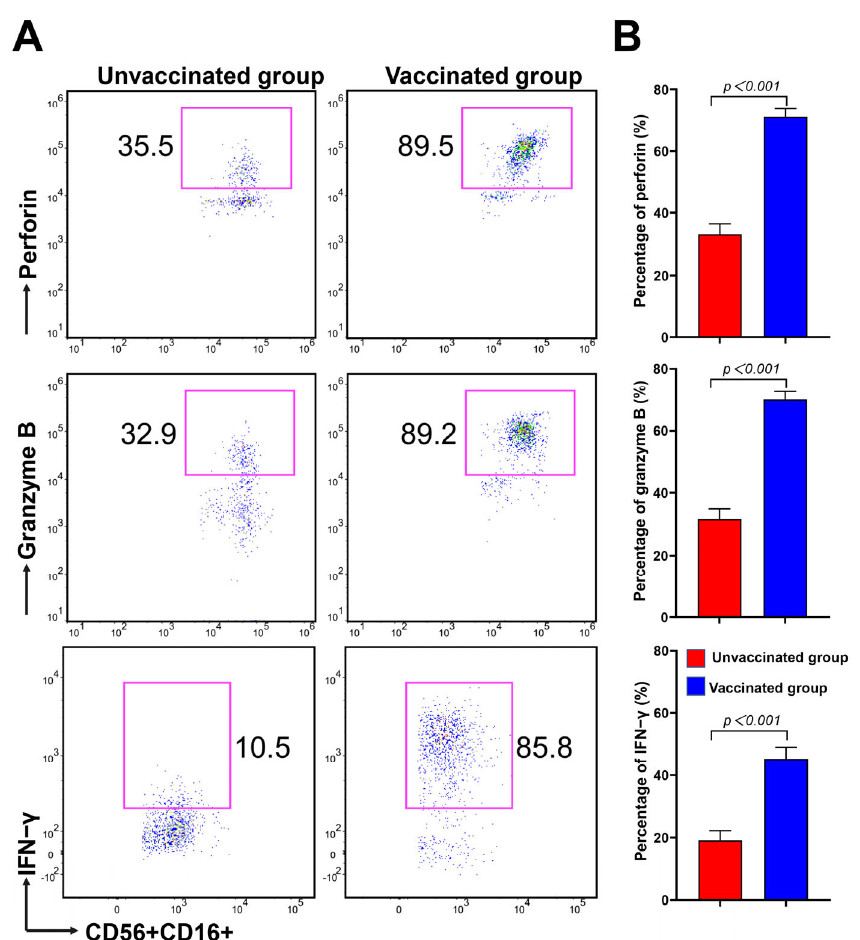
Figure 3. Comparison of perforin, granzyme B, and IFN- γ on the NK cell subsets between the unvaccinated and vaccinated groups. ( A ) The expressions of perforin, granzyme B, and IFN- γ on CD56 + CD16 + NK cells were evaluated using flow cytometry. ( B ) Graphical representation of perforin, granzyme B (unvaccinated group, n = 18; vaccinated group, n = 50), and IFN- γ (unvaccinated group, n = 11; vaccinated group, n = 45) expressions on CD56 + CD16 + NK cells. All p -values were two-tailed, and di ff erences with p < 0.05 were considered statistically signi fi cant. ns , not signi fi cant.